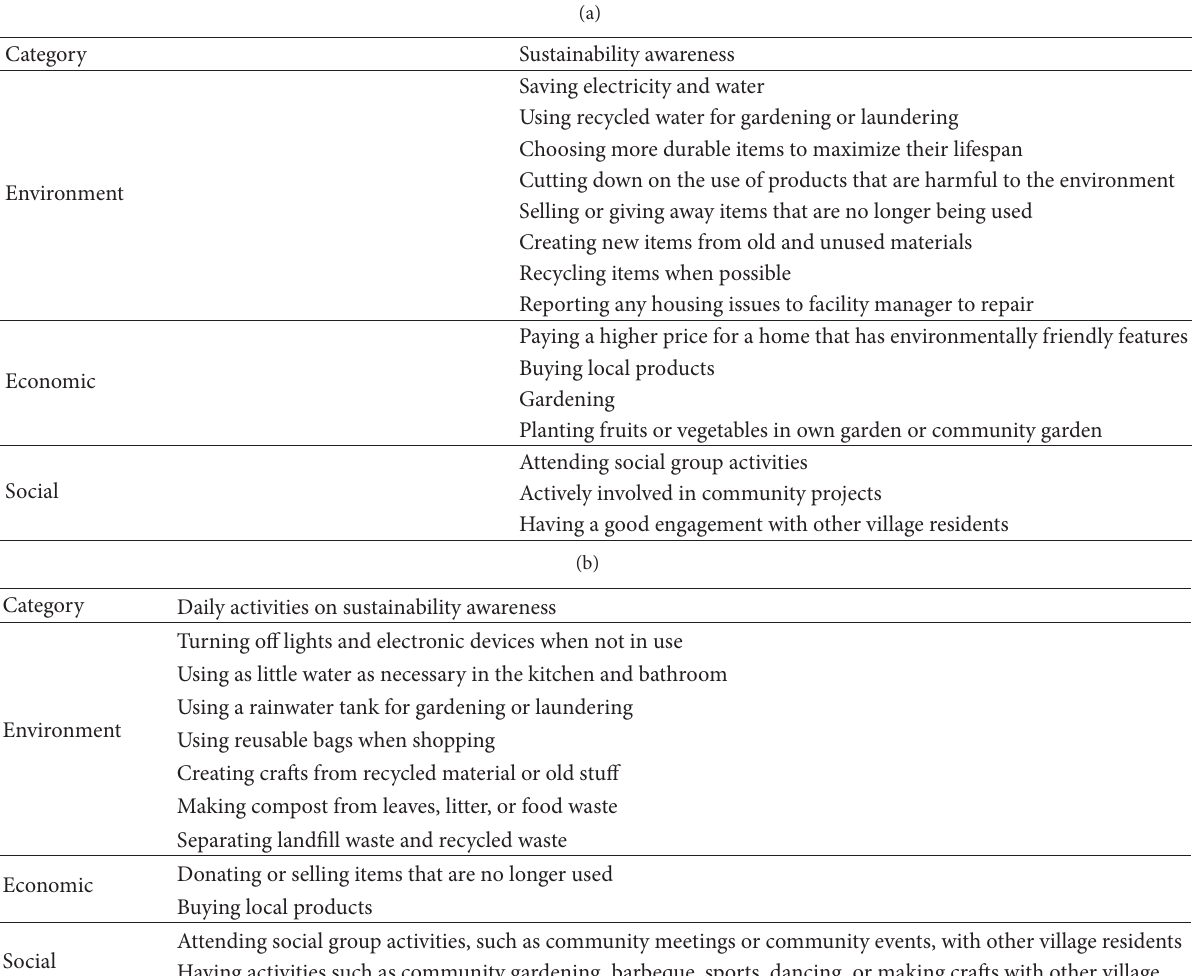
Table 1: Cluster of the questionnaire. (a)